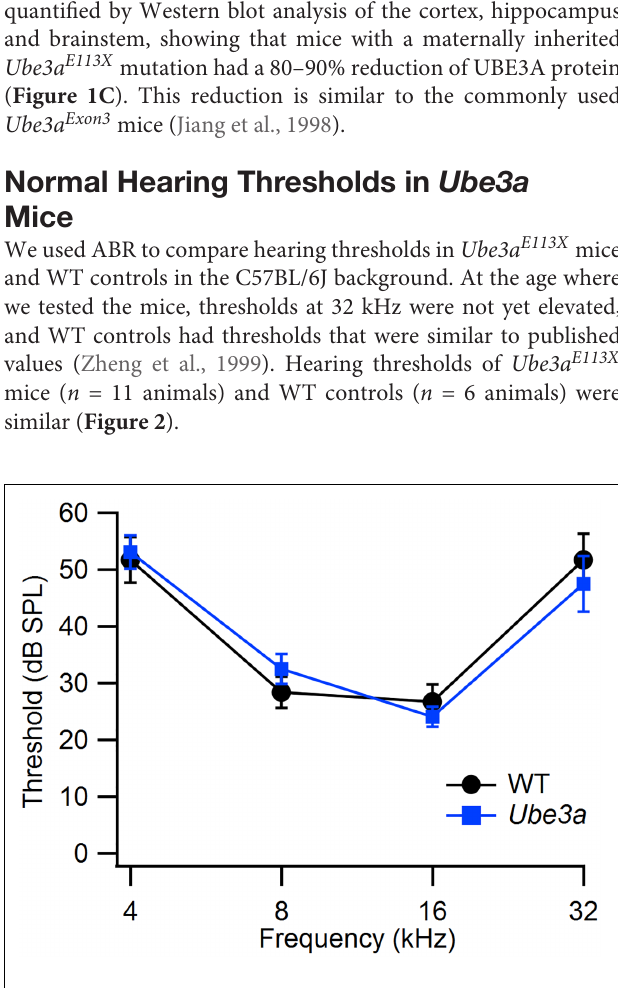
FIGURE 2 | Similar hearing thresholds in WT and Ube3a mice. Comparison of the hearing thresholds between WT ( n = 6) and Ube3a E113X mice ( n = 11) at four different